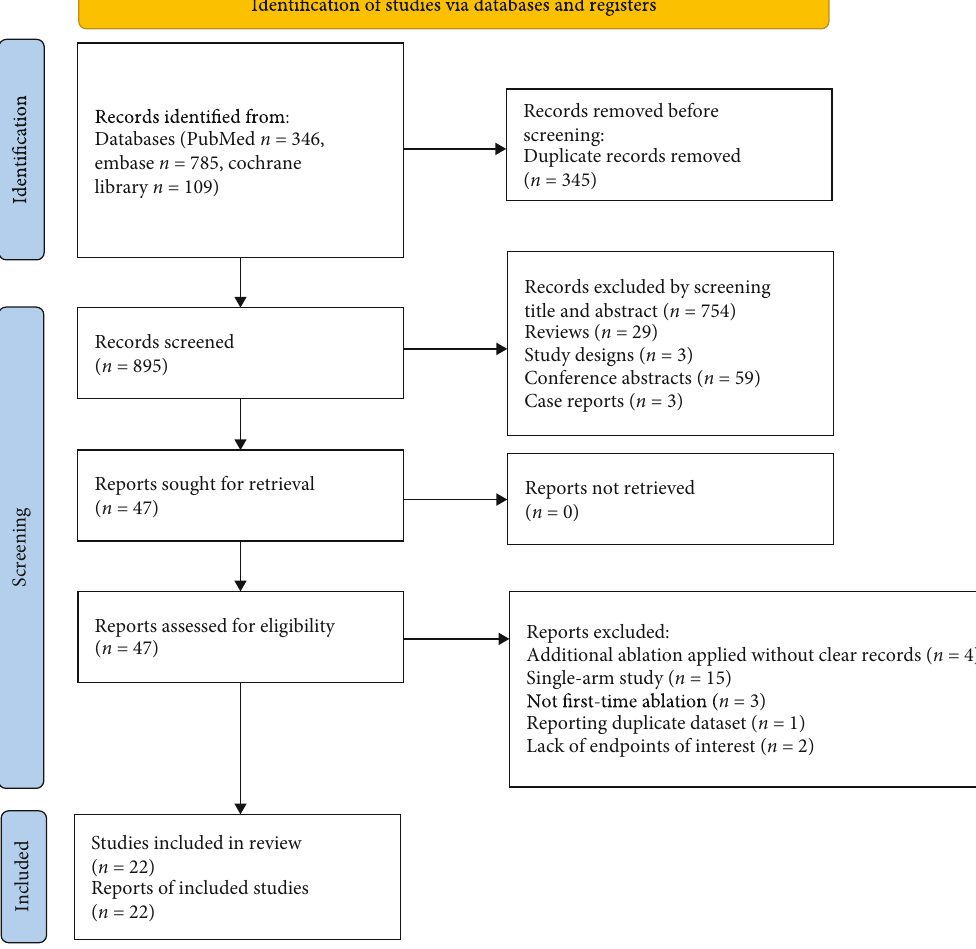
Figure 1: Flow chart demonstration literature screen